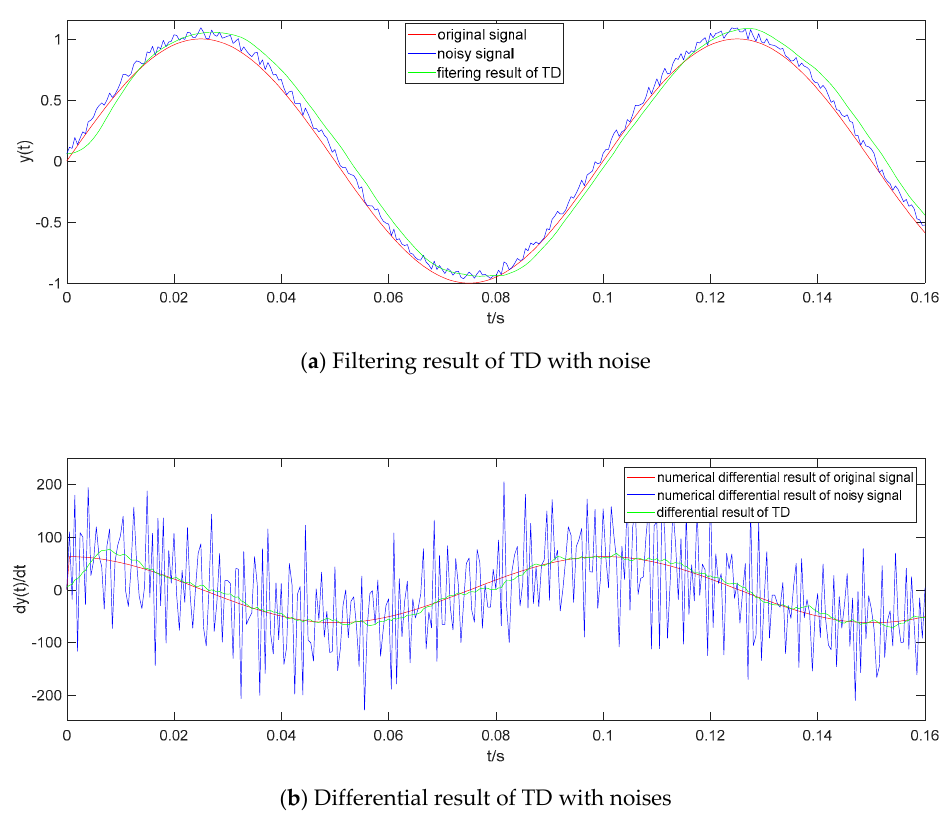
Figure 3. Filtering result and differential result of TD with noise.